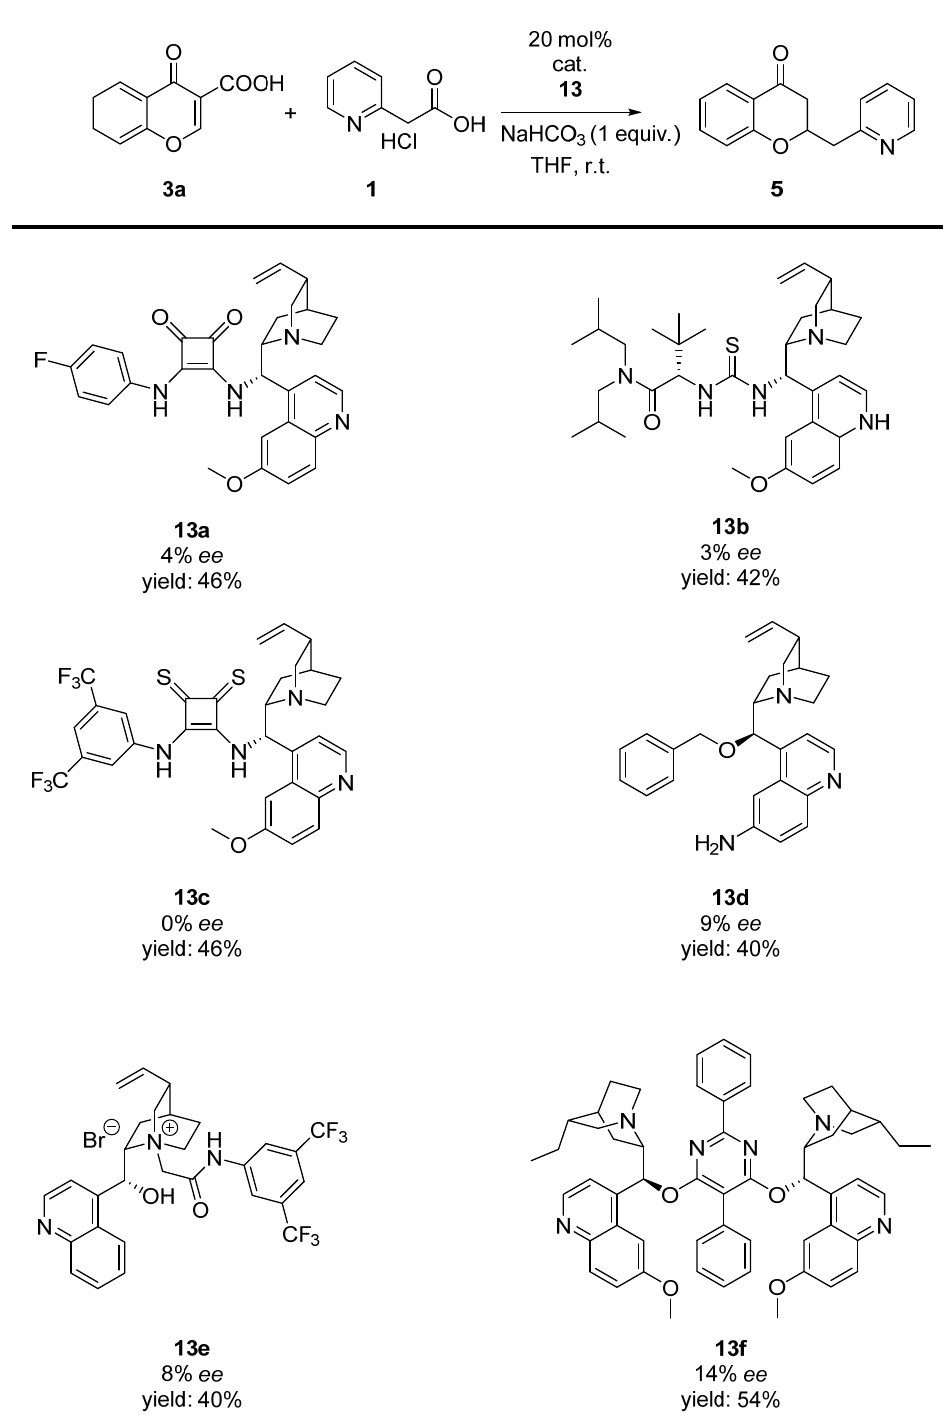
cinchona alkaloid derivatives; ( 13d ) protected and/or modified alkaloids without H-bond donor amides; ( 13e ) phase-transfer catalysts; ( 13f ) ethers containing two cinchona alkaloid moieties. Reaction was performed at room temperature and in tetrahydrofuran as a solvent. All tested catalysts promoted model reaction; however, enantioselectivity of the process was very